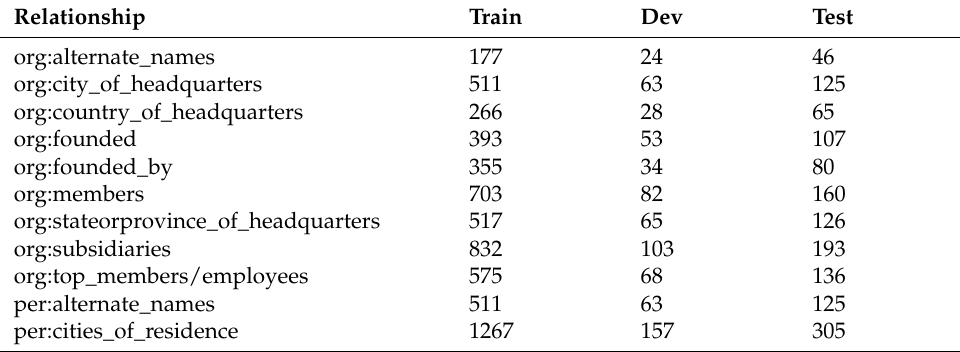
Table 4. Data distribution of the KBP37